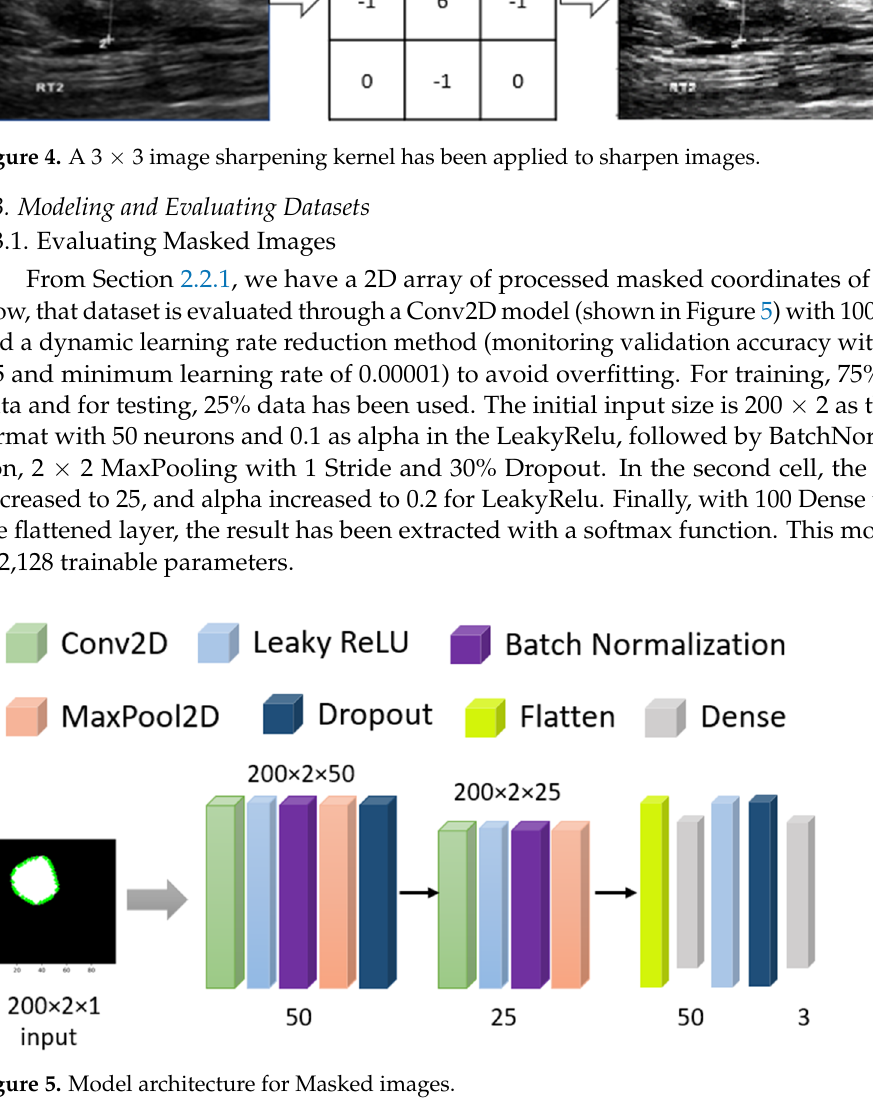
Figure 3. Masked image processing sequence.